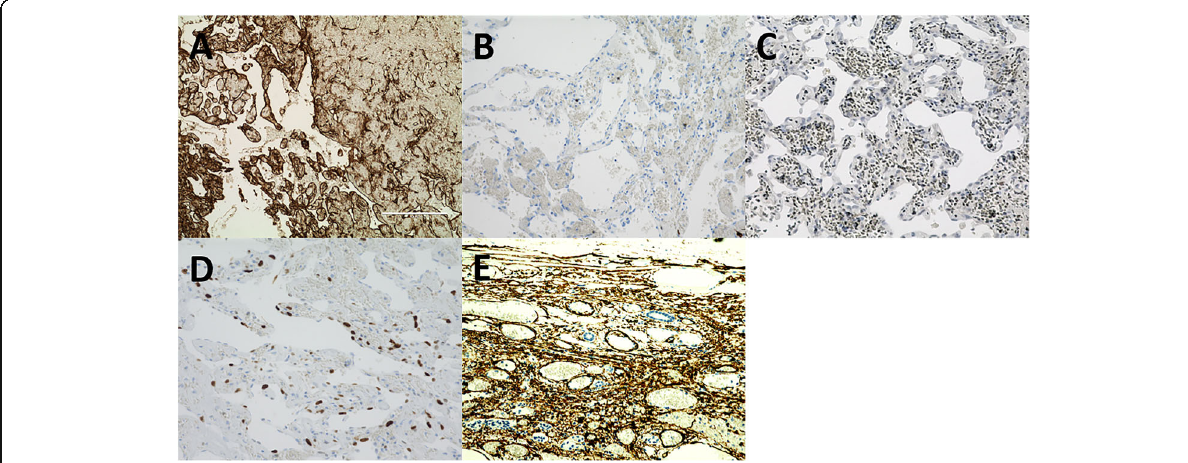
Fig. 5 Immunohistochemical staining. Immunohistochemical staining of ventral mural nodule was a positive for CD31 (original magnification ×40) and b negative for α SMA and c MDM2 (original magnification ×200). d The Ki-67 labeling index was 19.0% (original magnification ×200). e Immunohistochemical staining of the thickened portion of the cyst wall was positive for α SMA (original magnification